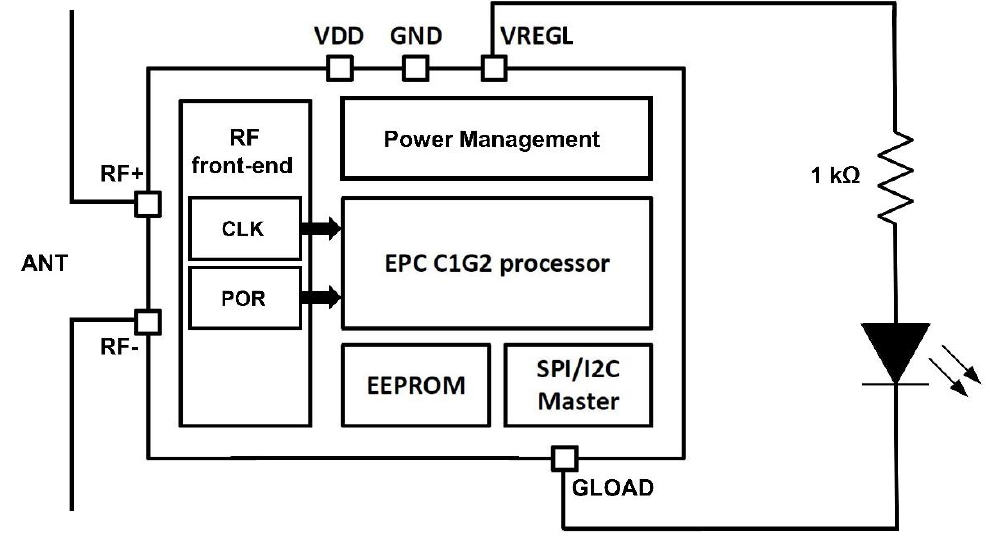
Figure 5. Block diagram of the RFID tag connected to the LED.